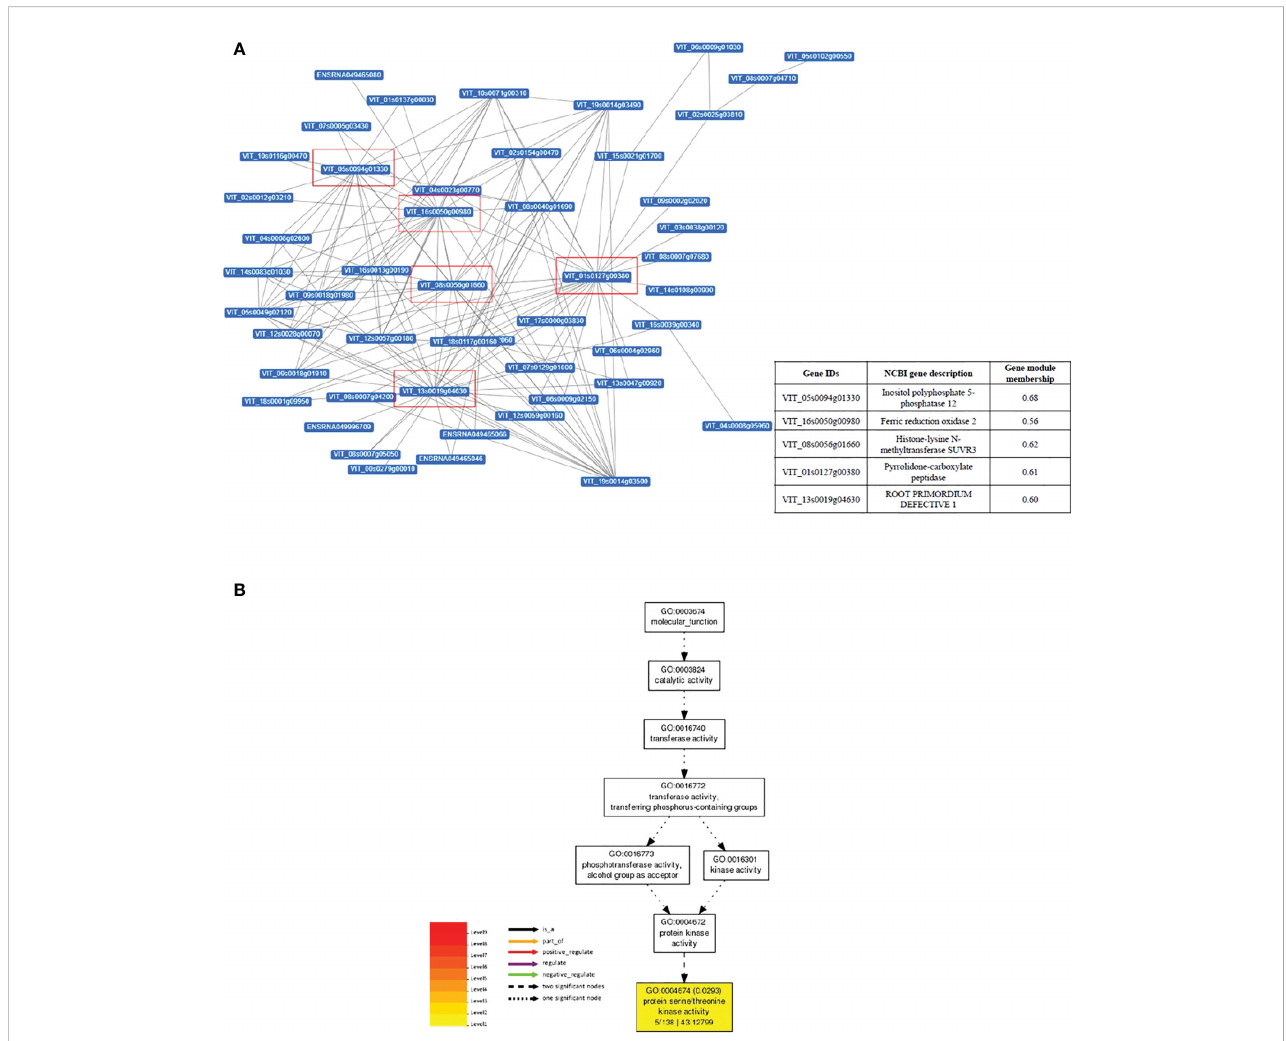
FIGURE 4 Gene interaction network of genes of module ‘ darkmagenta ’ associated with leaf temperature and stem water potential. Gene interaction network of top 50 genes of darkmagenta module by Cytoscape. Each node represents a gene, and each line denotes the gene expression interaction between the two nodes. Hub genes are highlighted by red boxes, information about hub genes is given in insert table. (B) Gene Ontology molecular function analysis of the